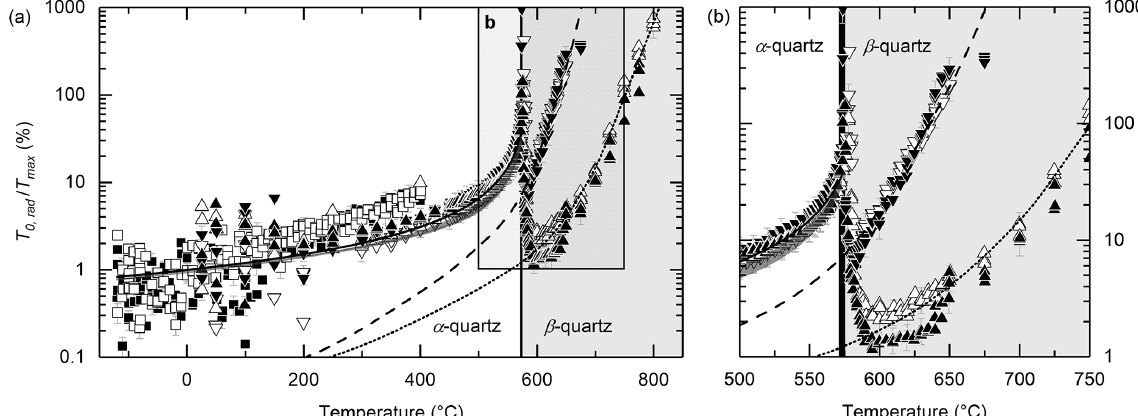
Figure 6. (a) Ratio of the direct radiative heat transfer ( T 0 , rad ; see Eq. (8) and inset Fig. 1) to the theoretical adiabatic maximum temperature on the specimen rear side T max (see Fig. 1) for the [001] (black filling) and [100] directions (white filling) and specimens LT (squares), HT1 (upwards triangles) and HT2 (downwards triangles). The solid line represents a reciprocal fit for T ≤ 573 ◦ C; dashed and dotted lines are splines to guide the eyes for direct radiative ballistic (boundary-to-boundary) heat transfer (for details, see the text). For the thick dark grey line, the effect of direct ballistic heat transport is subtracted from the deduced direct radiative heat transfer. The grey line thus represents the net effect of a non-ballistic radiative heat transfer for α -quartz. The behaviour in the vicinity of the α – β phase transition region is shown in detail in panel (b)